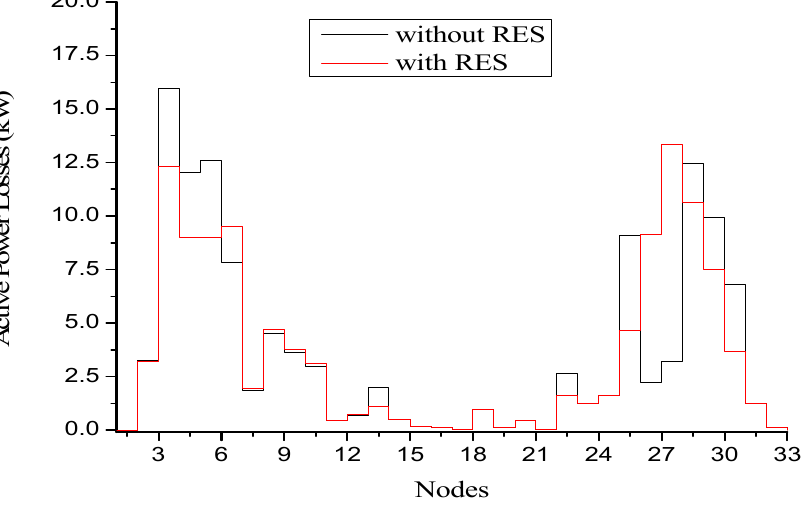
Figure 4. Active power losses with and without the integration of RES.